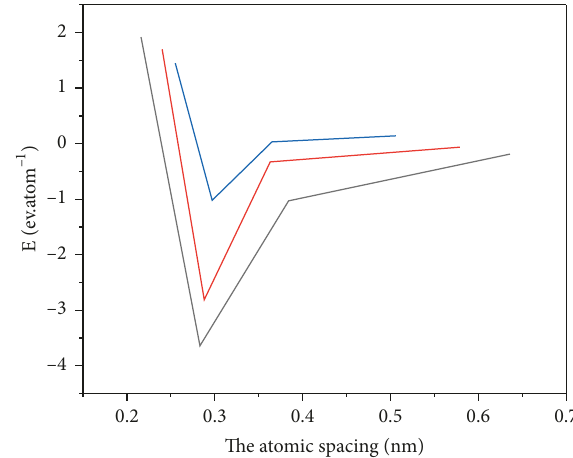
Figure 2: Potential energy curve of Au.